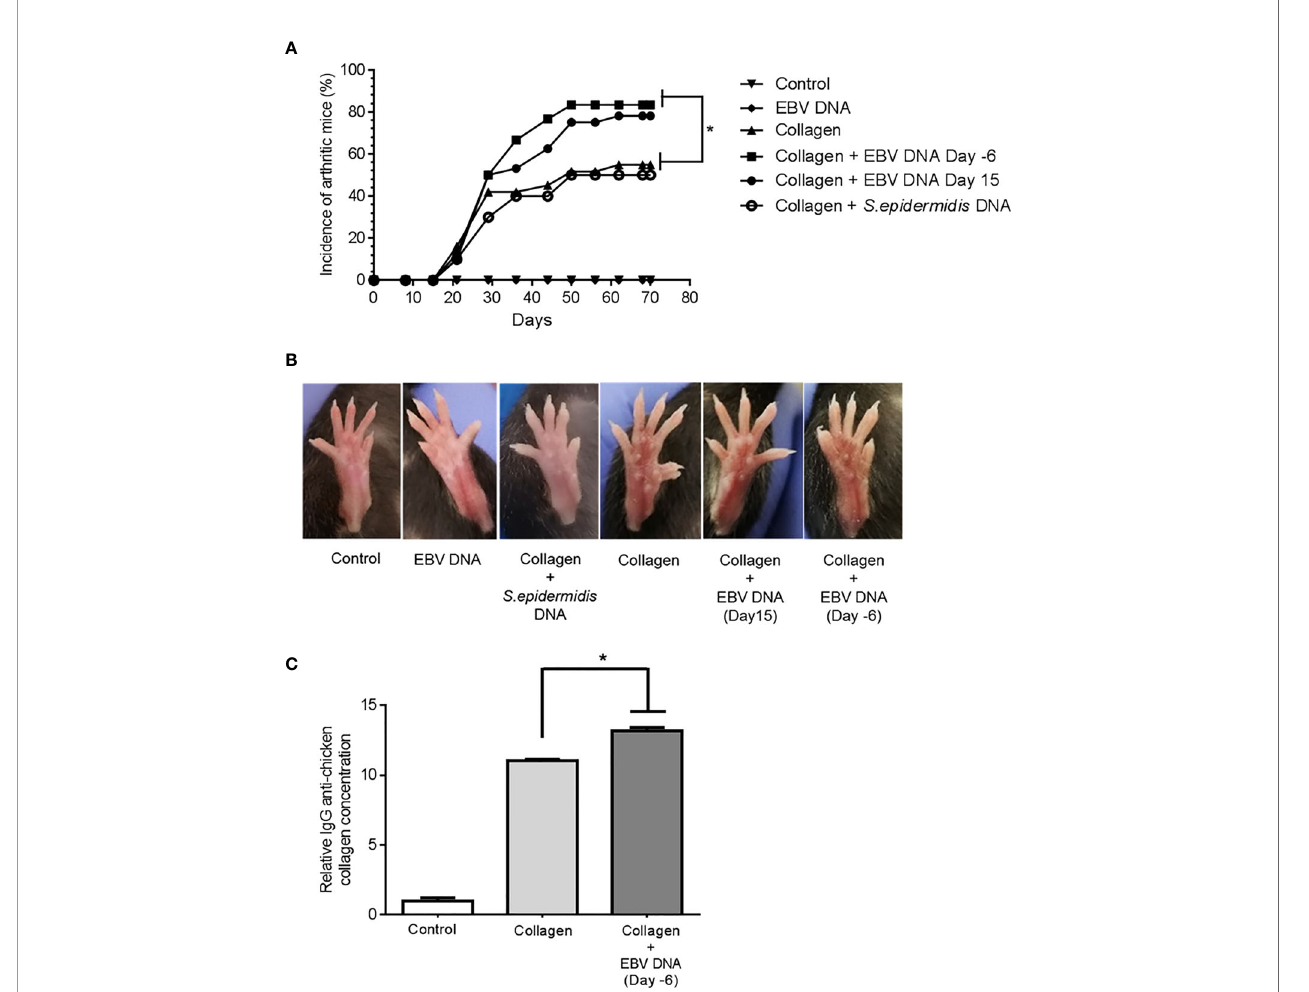
FIGURE 2 | Effect of EBV DNA on the incidence of arthritis in the collagen-induced arthritis mouse model (A) Incidence (%) of arthritis in various groups of C57BL/ 6J mice treated with type II chicken collagen (n=31), EBV DNA 6 days before collagen (n=30), EBV DNA 15 days after collagen (n=32), S. epidermidis DNA 6 days prior to collagen (n=10), and control mice treated with distilled water (n=32) or EBV DNA only (n=8). (B) Representative images of hind paws from arthritis-affected animals. Redness and swelling in the paws and footpads are indicative of arthritis. (C) Relative concentration of IgG anti-chicken collagen antibodies in the arthritis groups (collagen only and EBV DNA 6 days prior to collagen mice) normalized to the distilled water control group. * indicates p< 0.05; comparisons were made to the group that received collagen